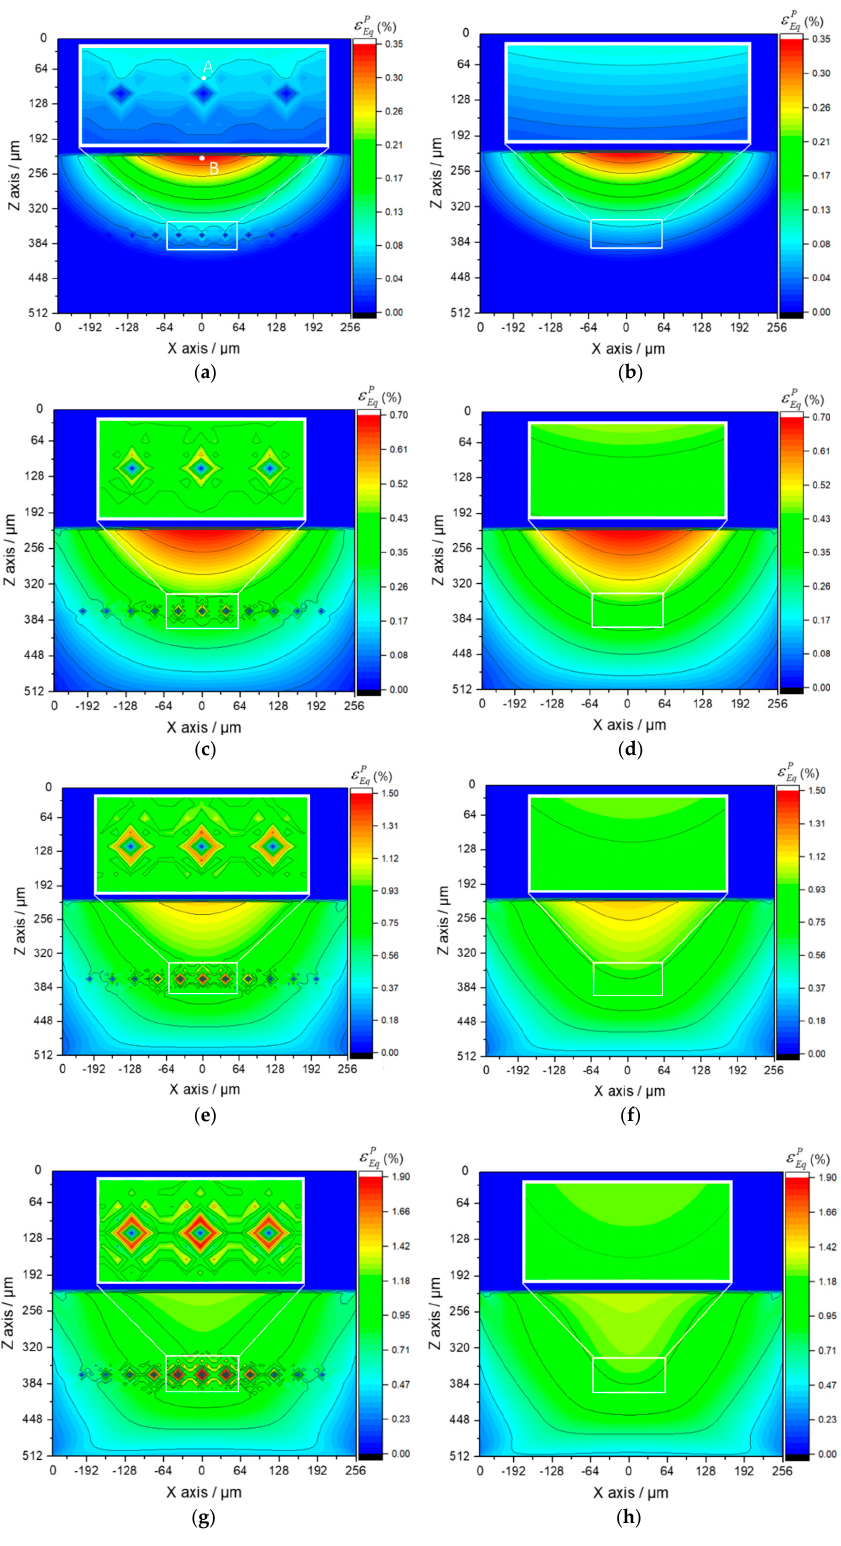
Figure 20. Plastic region evolution in the cross section XOZ of Ti-(SiC f /Al 3 Ti) ( a , c , e , g ) and Ti-Al 3 Ti ( b , d , f , h ) laminated composites, with varying load: ( a , b ) 5.4 kN, ( c , d ) 10.8 kN, ( e , f ) 16.2 kN, ( g , h ) 21.6 kN.